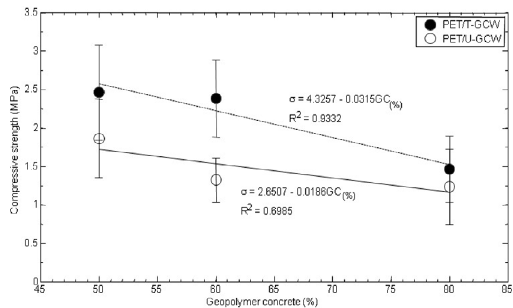
Figure 16. Graphic of compression test with standard deviation of the PET/U-GCW and PET/T-GCW.